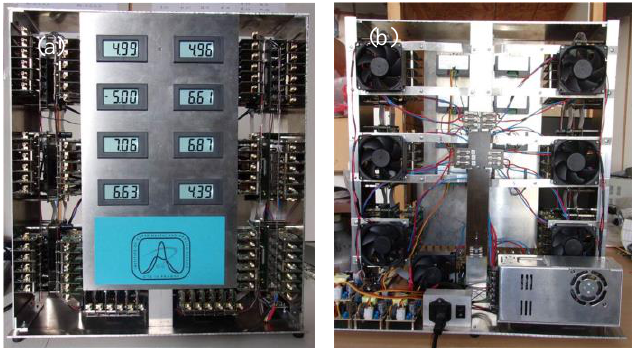
Fig. 4. The Front (a) and back view (b) on the 84-channel digitizer .